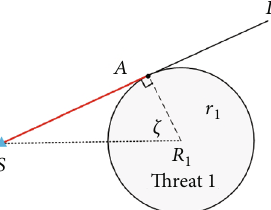
Figure 13: The boundary docking point of the start/end point to the associated threat.